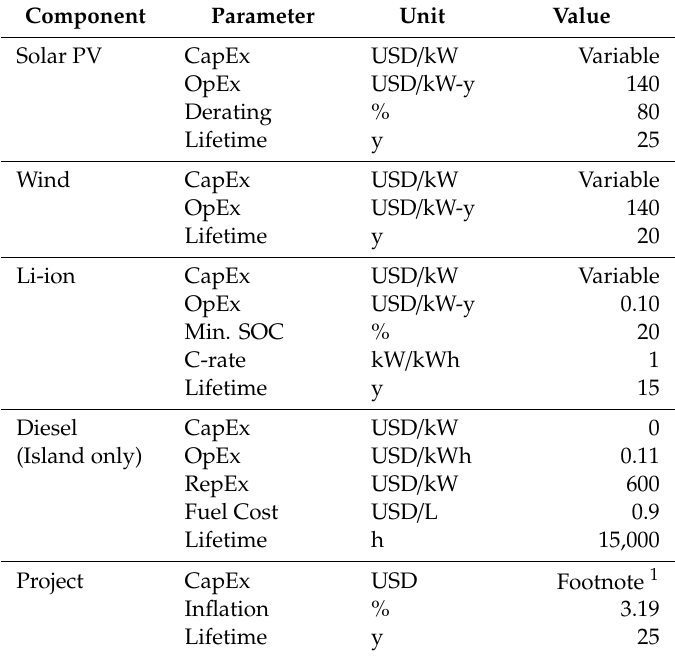
Table A3. Techno-economic parameters used in the case studies.